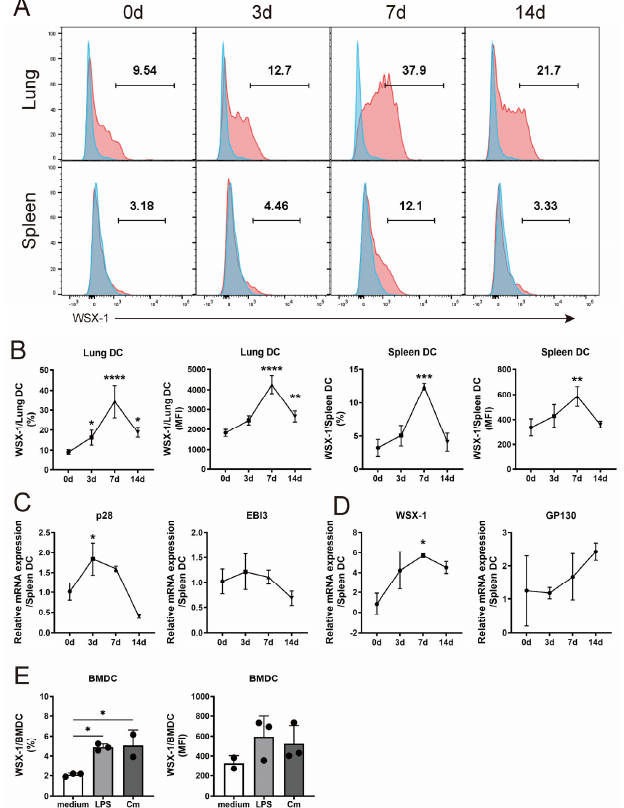
Figure 1. The expression of IL-27/IL-27R in DCs following Chlamydia muridarum ( C. muridarum or Cm) respiratory infection. The wild-type (WT) mice were intranasally infected with 1 × 10 3 inclusion-forming units (IFUs) C. muridarum and euthanized at days 0, 3, 7, and 14 post-infection (p.i.). ( A , B ) Lung and spleen single cells were prepared, and the WSX-1 expressions (red) with fluorescence minus one (FMO) control (blue) were analyzed by flow cytometry based on gated DCs as described in Figure S1 ( A ). The percentages and mean fluorescence intensity (MFI) of WSX-1 positive cells were indicated ( B ). ( C , D ) Spleen CD11c + cells were purified using MACS CD11c + cell isolation column, total RNA was prepared, and the mRNA expression of p28, EBI3, WSX-1, and GP130 was detected by quantitative real-time PCR (qPCR). ( E ) The mouse bone marrow dendritic cells (BMDCs) were induced from naïve C57BL/6 mice, grouped as noninfected BMDCs (white), LPS-stimulated BMDCs (light grey), or Cm- infected BMDCs (deep grey) as described in the methods, stained with anti-WSX-1, and analyzed by flow cytometry. Data are shown as means ± SD, representing one of three independent experiments (n = 2–4/group/experiments). Statistical significances of differences are determined by one-way ANOVA. * p < 0.05, ** p < 0.01, *** p < 0.001, **** p < 0.0001. Abbreviations: DCs, dendritic cells; WSX-1, interleukin 27 receptor subunit alpha (IL-27R α ); C. muridarum /Cm, Chlamydia muridarum ; IFUs, inclusion-forming units; p.i., post-infection; MFI, mean fluorescence intensity; EBI3, Epstein–Barr virus-induced gene 3; GP130, glycoprotein 130; LPS, lipopolysaccharide; BMDC, bone marrow dendritic